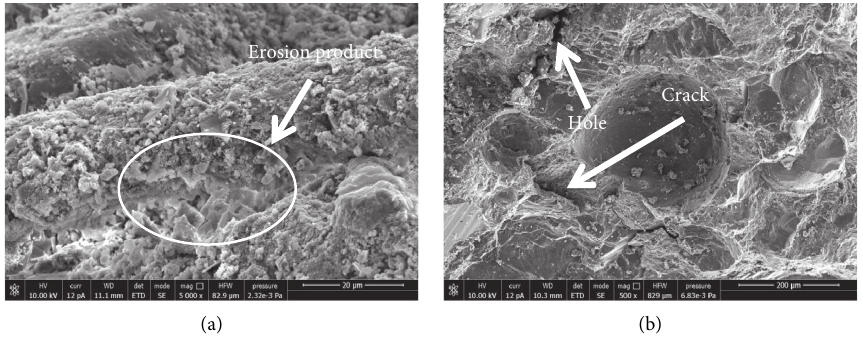
Figure 13: The microstructure of rubber concrete under sulfate erosion environment. (a) Dry-wet cycle 45 times. (b) Dry-wet cycle 90